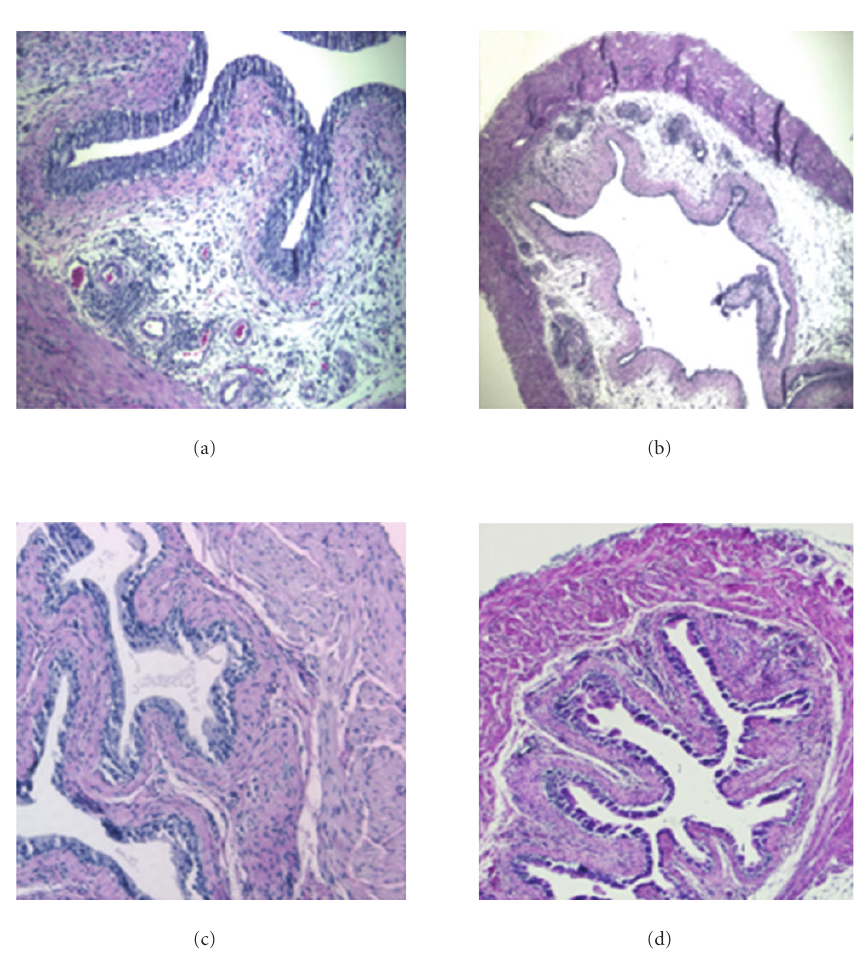
Figure 4: Intravesical DMSO treatment reduces bladder histopathology in chronic autoimmune cystitis. URO-OVA/OT-I mice were treated intravesically with PBS (a) or 50% DMSO (c) once weekly for a total of 3 treatments starting at week 10 and sacrificed for analysis 3 days after last treatment. The bladders were collected, prepared for histological cross-sections, and stained with H&E solution. A parallel set of mice treated with PBS (b) or DMSO (d) were further transferred with 5 × 10 6 naive OT-I splenocytes 7 days after last treatment. Mice were sacrificed 3 days after cell transfer and the bladders analyzed by histological H&E staining. The slides are representative of 5 bladders in each group. Magnification: × 200 for the left pane and × 100 for the right panel.